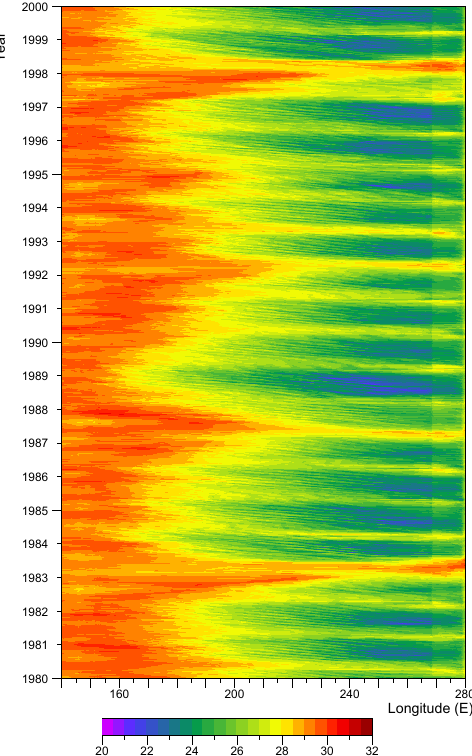
Figure 5. Average model sea surface temperature ( ◦ C) in the equatorial Pacific between 5 ◦ S and 5 ◦ N during the period 1980 through